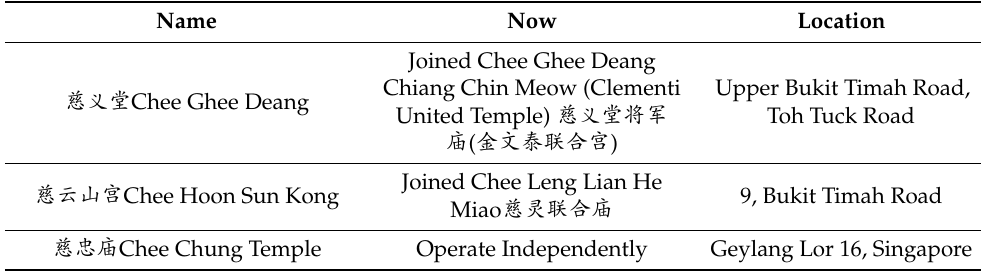
Table 9. The Huang Lao Xian Shi